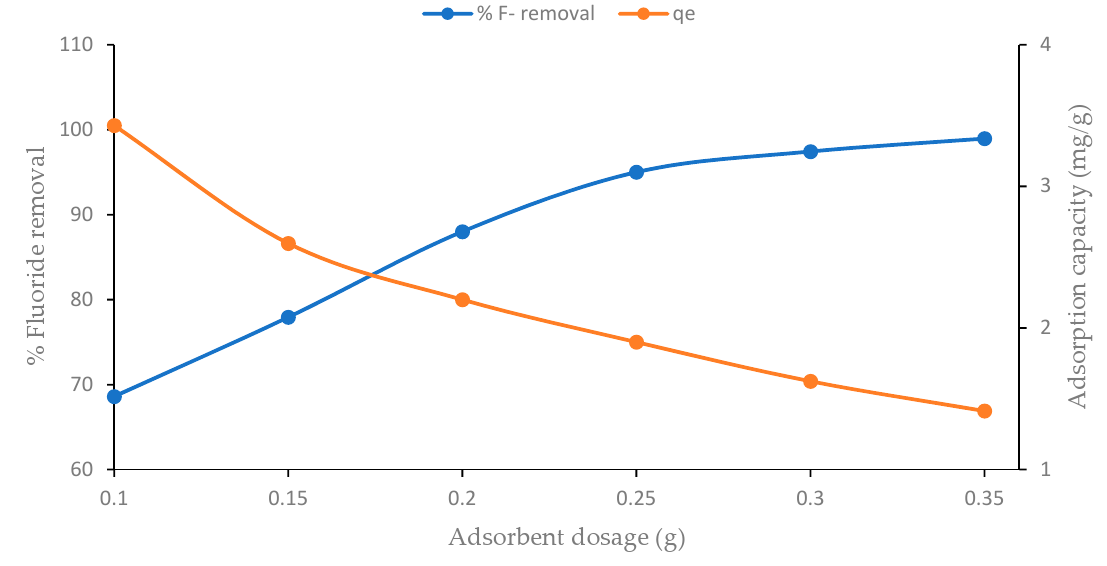
Figure 7. Effect of sorbent dose on the removal of F − ions by CNF-AgMgOnHap composite (contact time of 10 min, initial F − concentration of 10 mg/L at 50 mL solution volume, pH of 5, shaking speed of 250 rpm).